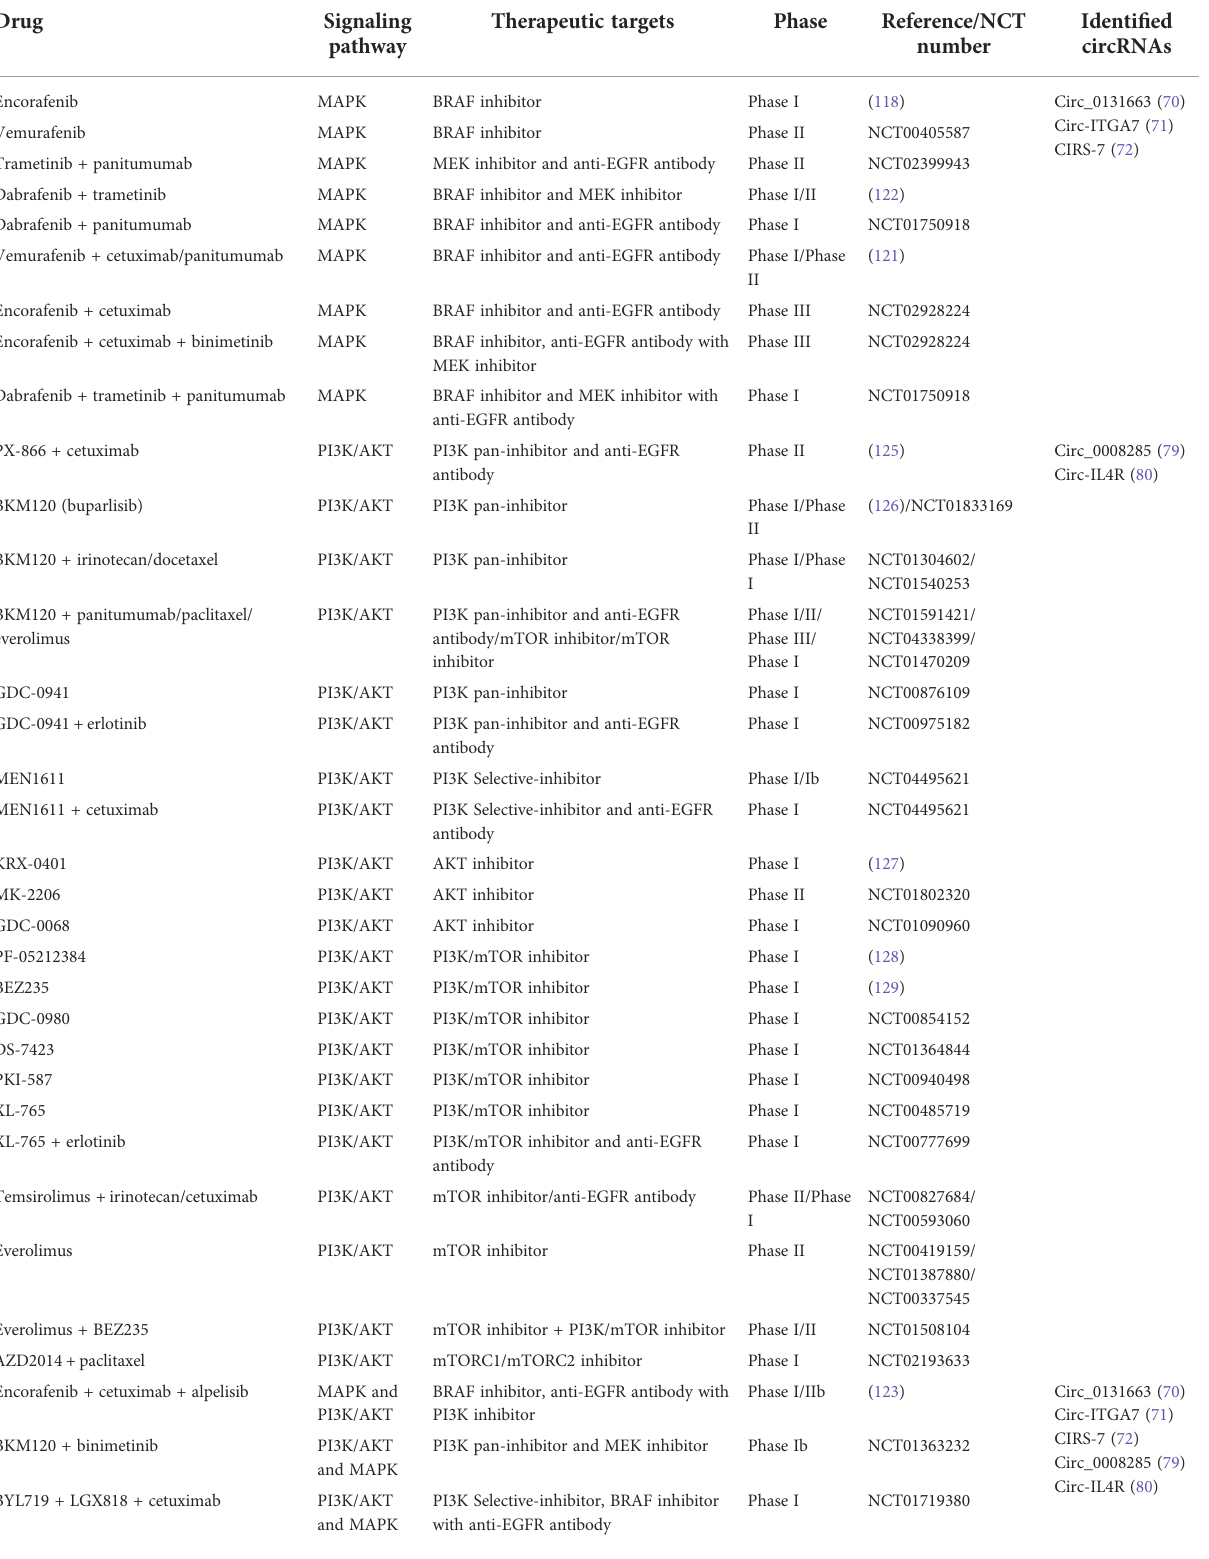
TABLE 2 Clinical trials of circRNAs related signaling pathways in